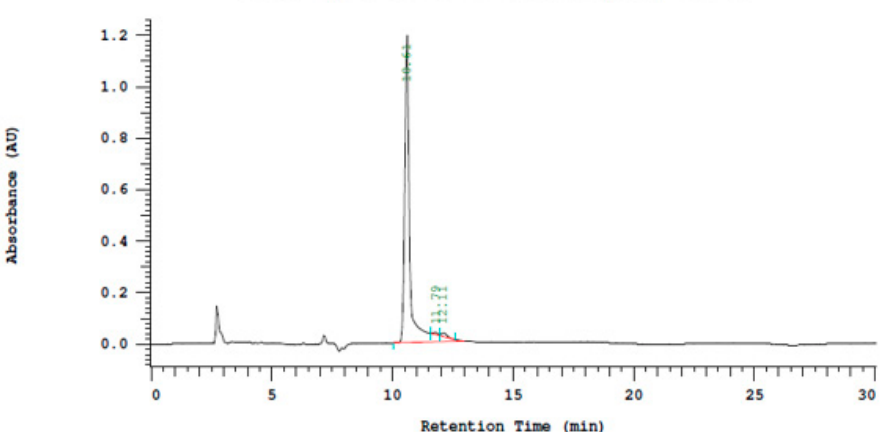
Figure 4. Chromatogram obtained for the analysis of product A using [Choline][ProCO 2 ] as catalyst and [Bmim][DCA] as reaction media (ee = 97%). The enantiomeric excess was determined using chiral HPLC (Phenomenex Lux 5 µ m i-Cellulose-250 × 4.6 Chiral Column, hexane: i-propanol, 10/90, fl ow: 1 mL/min, λ = 230nm): t R = 10.61 min (major) and t R = 12.11 min (minor).